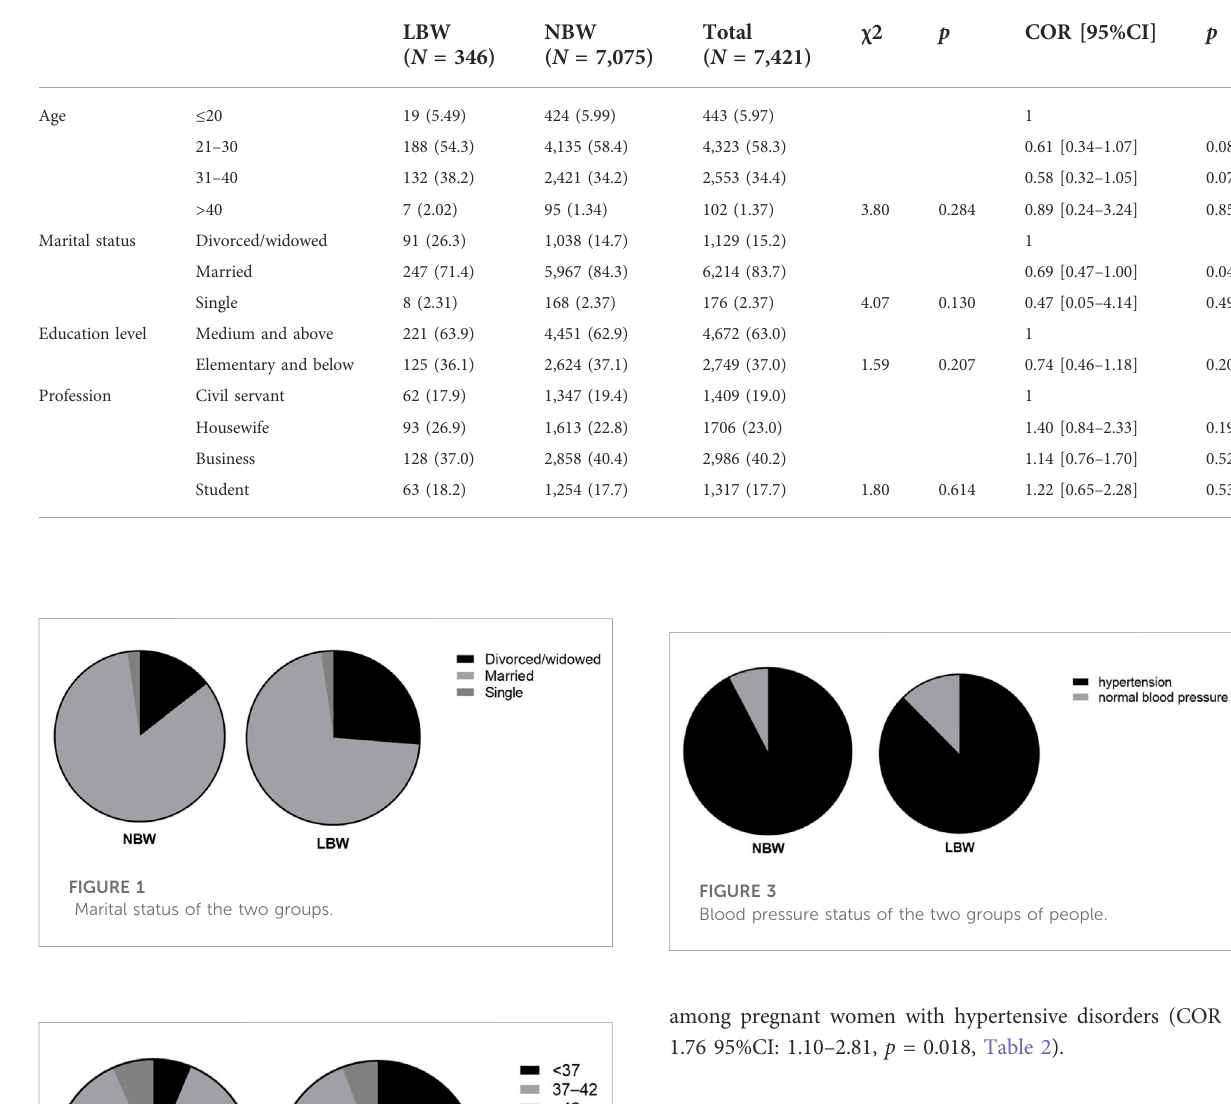
TABLE 1 Maternal sociodemographic factors associated with low birth weight.